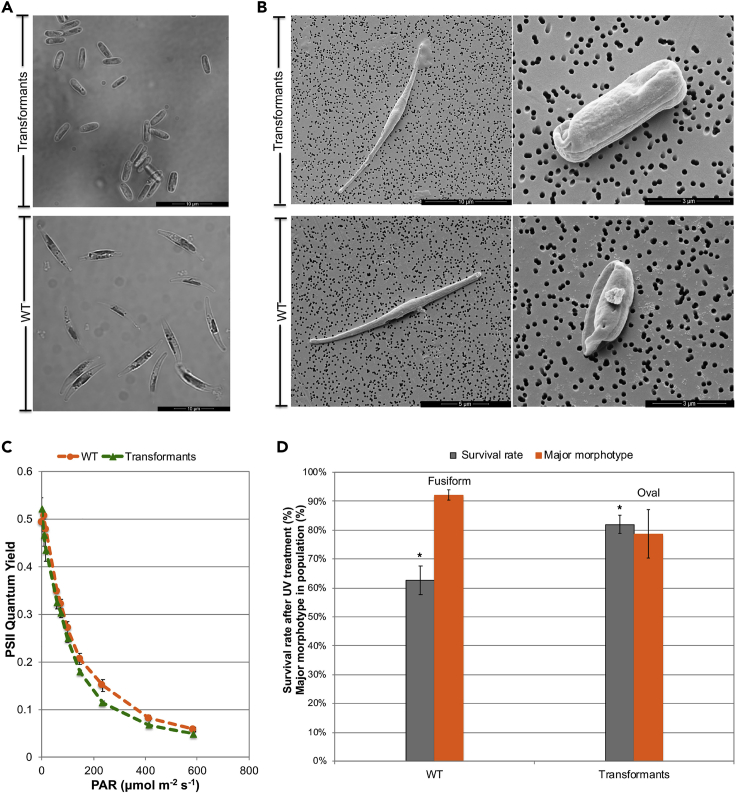
Morphological Shift in the Diatom Population and Its Characteristics(A) Bright-field microscopic images showing the dominant morphotypes in the GPCR1A transformants when compared with the wild-type (WT).(B) Scanning electron microscopic images of different morphotypes in transformants and WT.(C) Determination of the theoretical photosynthetic efficiency (Fv/Fm) and effective quantum yield (QY) of photosystem II under a light intensity of 220 μmol photons m−2 s−1.(D) Enhanced cell resistance to UV radiation in transformants (with oval cells at >75% of the population) when compared with the wild type (with oval cells at <10% of the population). Values were averaged from either two or three independent experiments. WT, wild-type; PAR, photosynthetically active radiation. Error bars indicate SEM. ∗ Indicates statistical significance between the groups (p < 0.05).